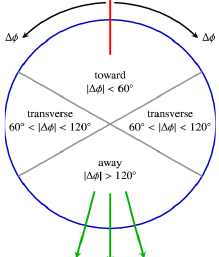
Fig. 6. The azimuthal plane sections in the UE studies. The different regions are identified starting from the identification of the leading object of the